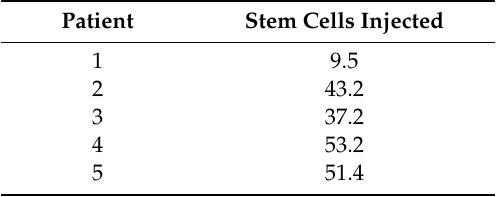
Table 2. Number of stem cells injected. ( × 10 6